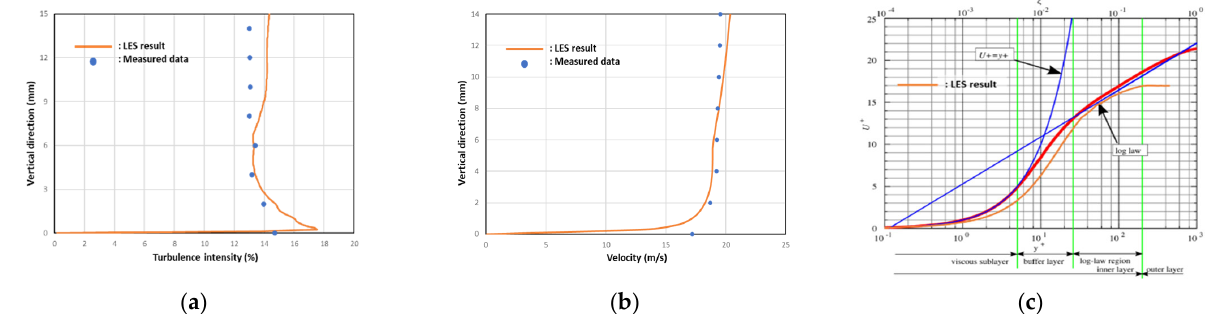
Figure 6. ( a ) Comparison of turbulence intensity, ( b ) velocity along the vertical direction, and ( c ) non − dimensional velocity distribution at the velocity measurement point.